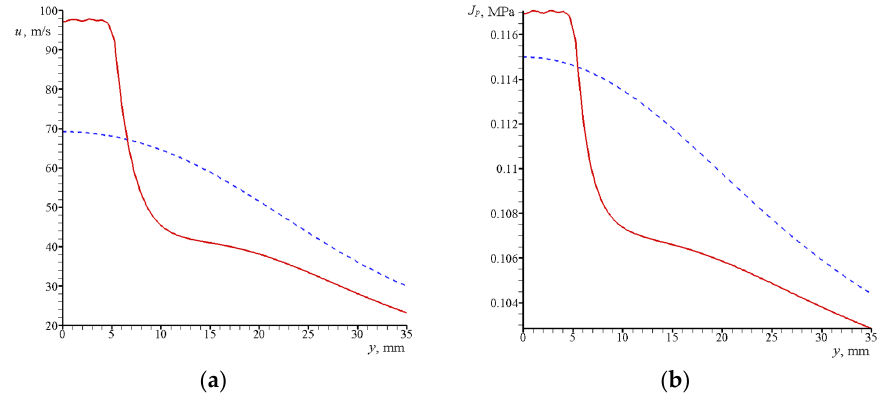
J y ( b ) calculated p